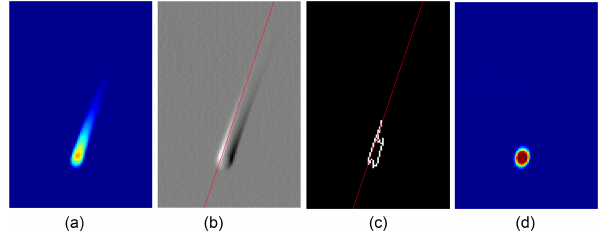
Figure 12. A small, inductively heated bell with a motion speed 1ms − 1 (a) and the deblurred image (b) .